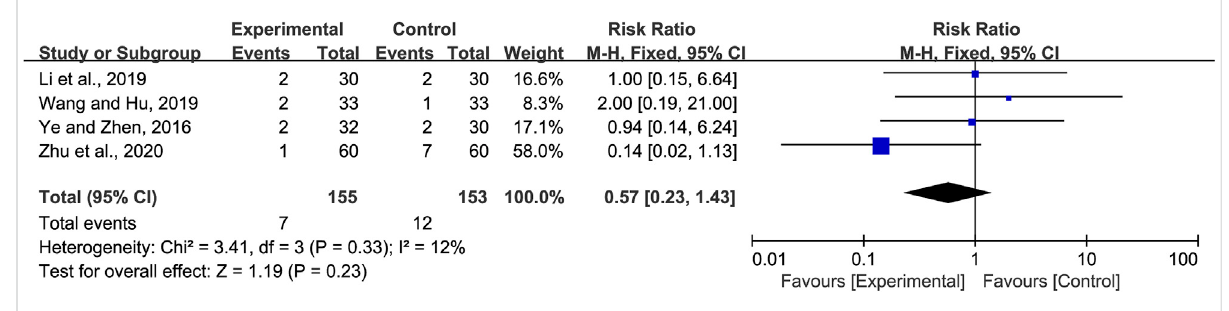
FIGURE 6 Forest plot for adverse reactions incidence.